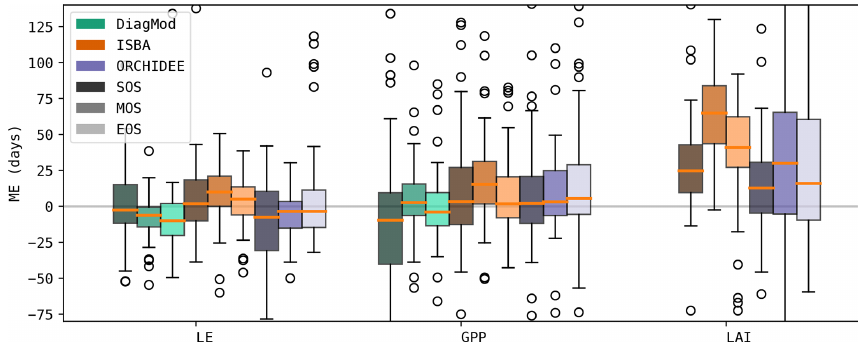
Figure 5. Mean error in the timing of the simulated seasonal cycle (start, max and end of season) for LE , GPP and LAI.